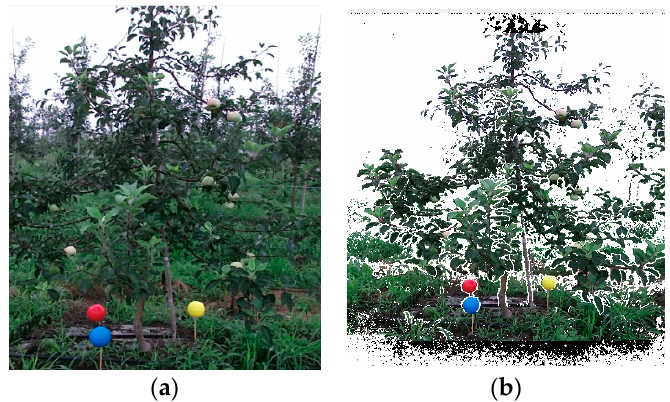
Figure 1. Schematic illustration of the measurement system structure: ( a ) color image captured; ( b ) image after depth and color matching.